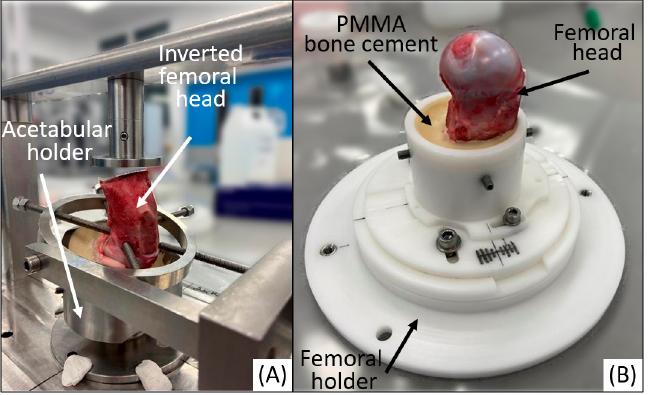
Fig 6. Experimental set up of the femoral head. (A) Femoral head position fixed in an inverted position so it is anatomically aligned with the acetabulum using a custom potting fixture; (B) Femoral head cemented into the femoral holder (as shown in Fig 4) simulator fixture.